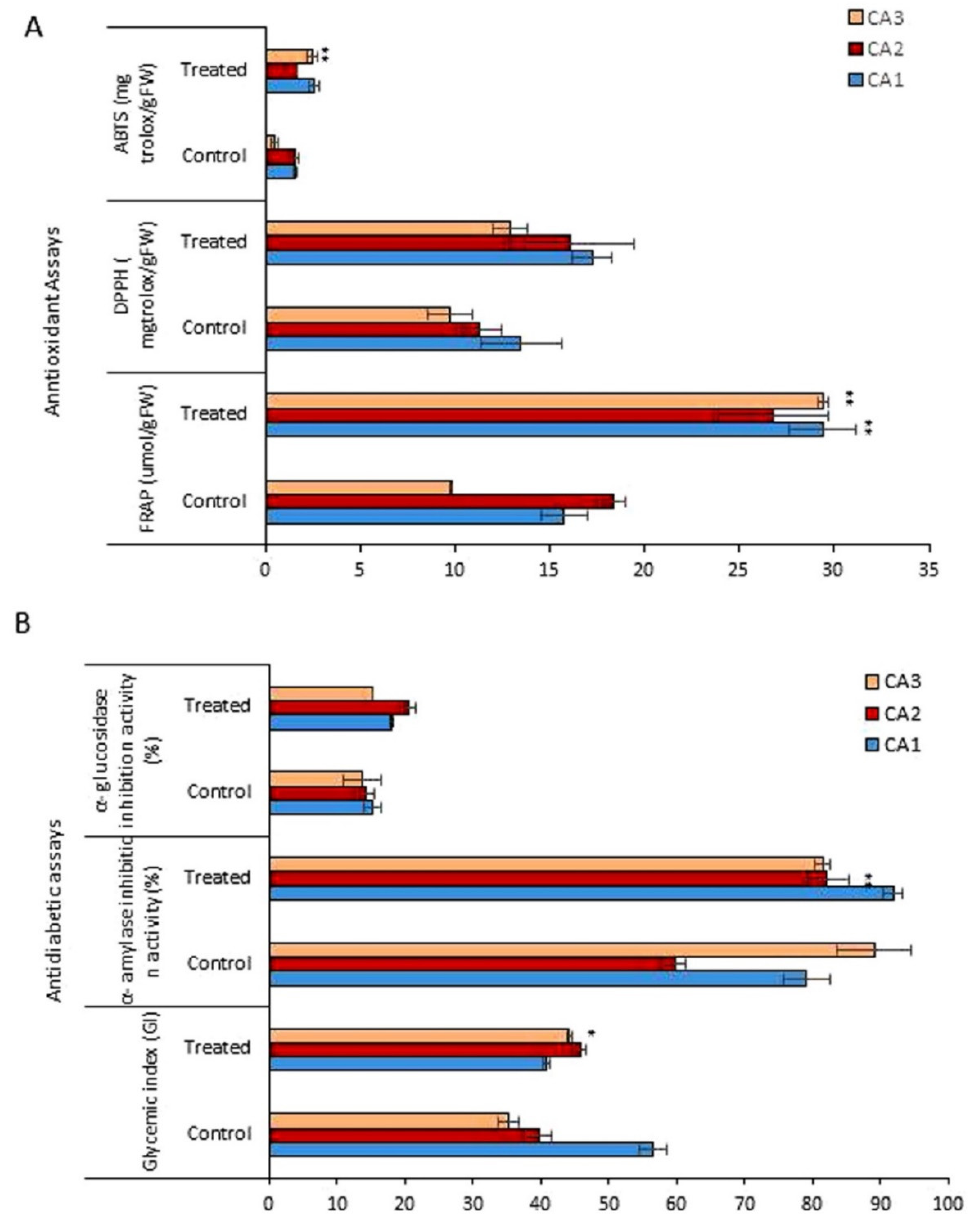
Figure 4. Effects of molybdenum (Mo) treatment on antioxidant and antidiabetic properties of Canavalia species ( A ): An- tioxidant property, i.e., FRAP, ABTS, and DPPH. ( B ): Glycemic index (GI), α - amylase inhibition activity, and α -